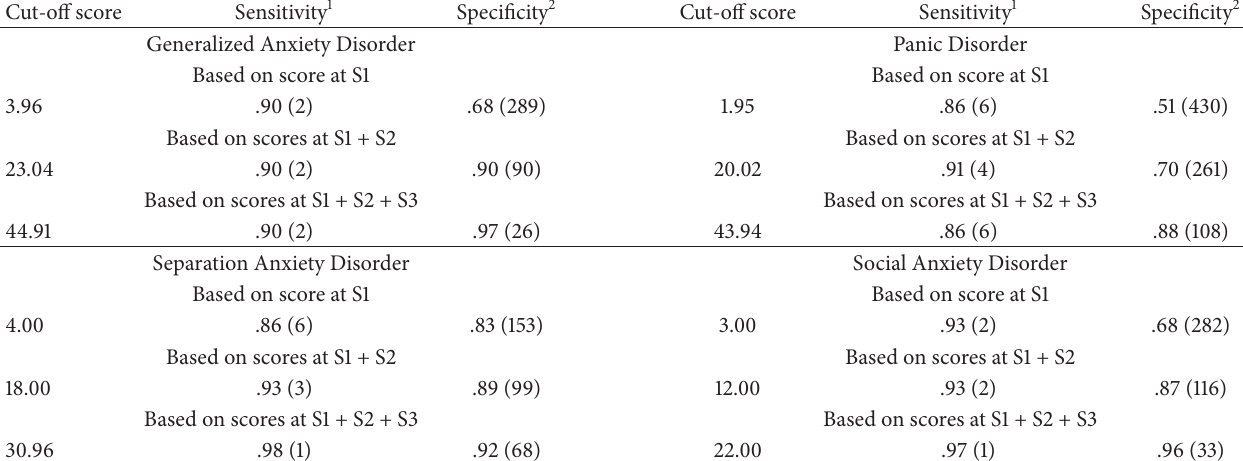
Table 2: Cut-off scores, sensitivity (number of false negatives), and specificity (number of false positives) of the SCARED subscales in detecting adolescents with a high-risk level anxiety